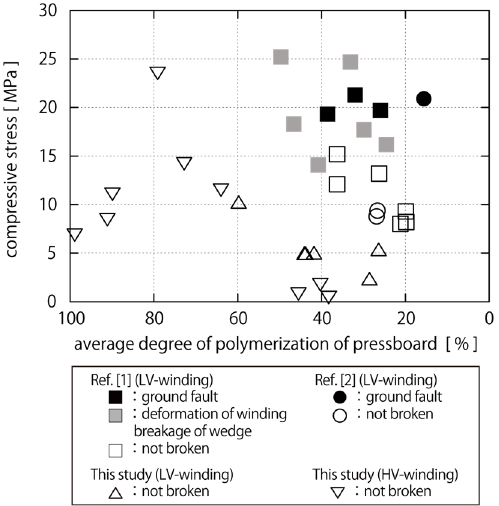
Figure 1. Summary of the short-circuit test results focusing on applied mechanical stress and average degree of polymerization of pressboards [7]. (Reference numbers in the legend are those in the original paper.).